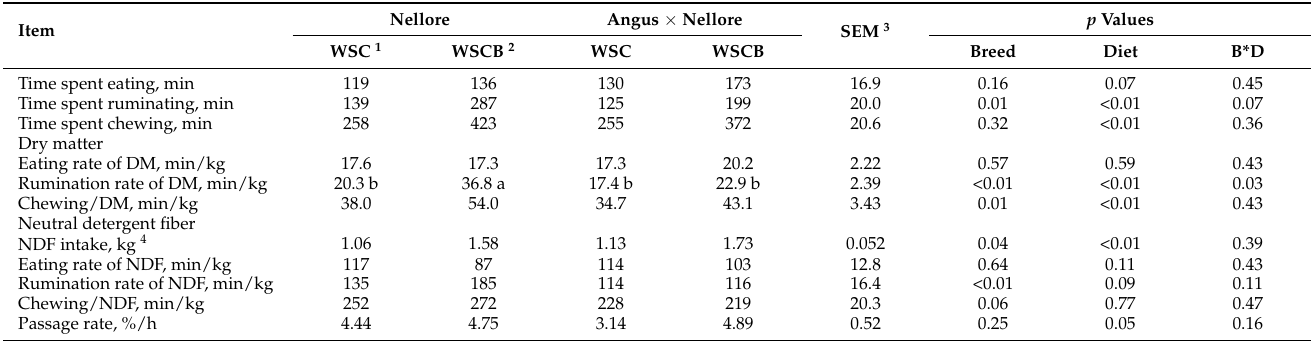
Table 3. Feeding behavior of Nellore and Angus × Nellore steers fed the whole shelled corn diet (WSC) or the whole shelled corn with sugarcane bagasse diet (WSCB) on day 50 of the experiment. p Values Nellore Angus × Nellore SEM 3 WSC 1 WSCB 2 WSC WSCB Breed Diet B*D